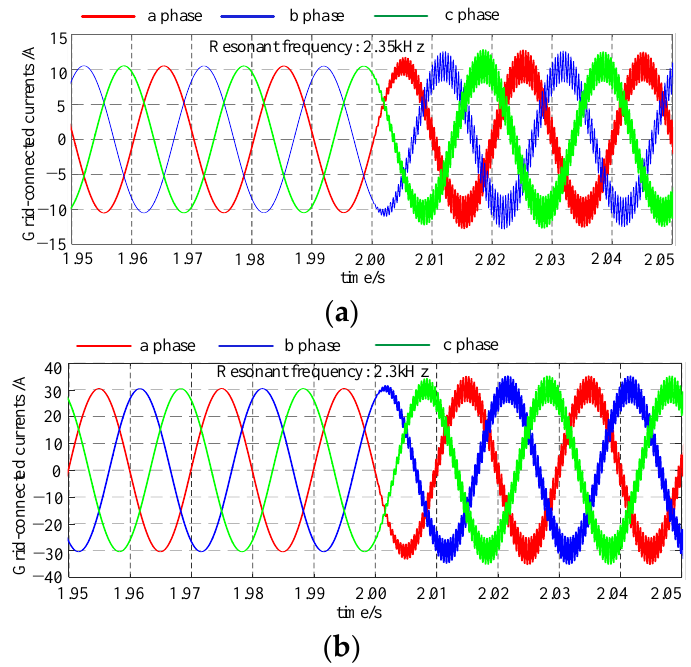
Figure 18. Current waveform under different parameters of a capacitor voltage regulator. ( a ) K p = 0.1, K i = 5, and K ic = 0.1. ( b ) K p = 0.1, K i = 20, and K ic = 0.1.